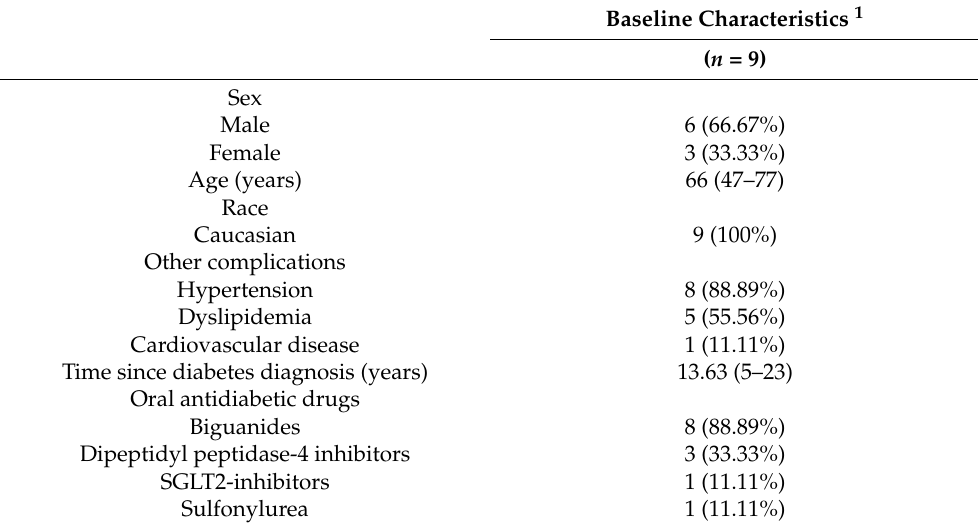
Table 1. Baseline